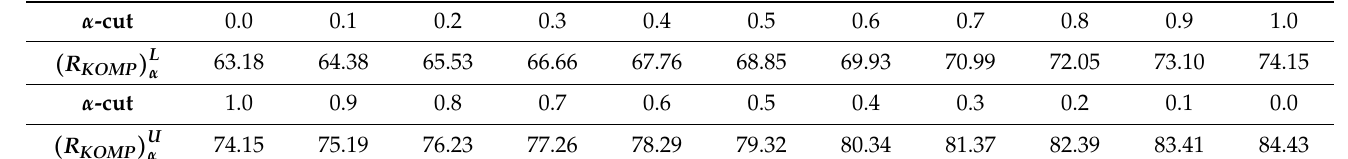
Table 13. The average of all combinations—the final fuzzy value of the equipment component rating.